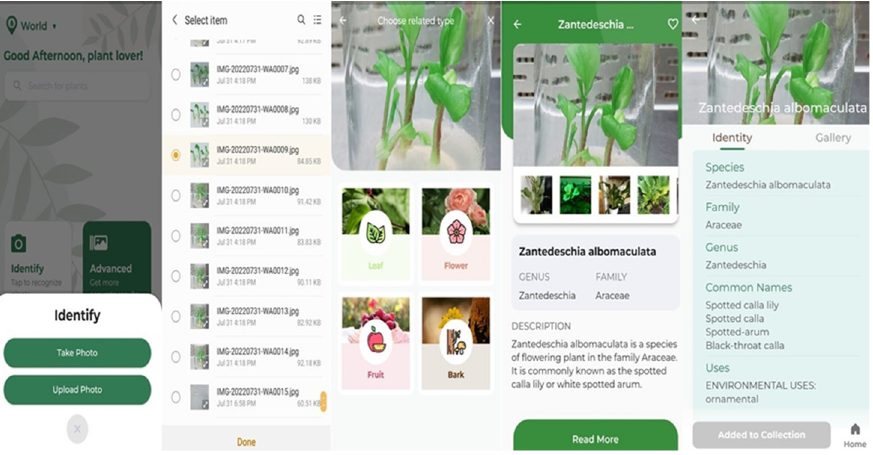
Figure 2. Digital identification of Zantedeschia albomaculata using the LeafSnap application. (The sequential images illustrate the identification steps from left to right).